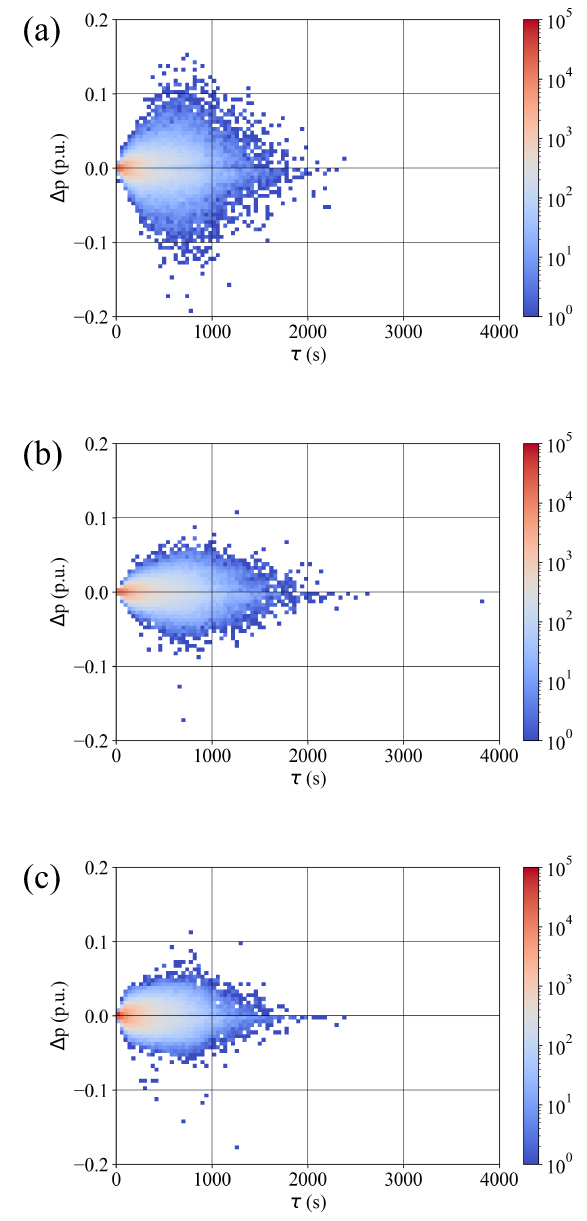
Figure 7. Scatter diagram of the amplitudes of half-cycles, ∆ p , versus the half-cycle periods, τ , of short-term fluctuations in the ( a ) Hokkaido, ( b ) Tohoku, and ( c ) Kyushu areas in the 2012 fiscal year. Data point density is reflected by the colors: high (low)-density data are indicated by red (blue)